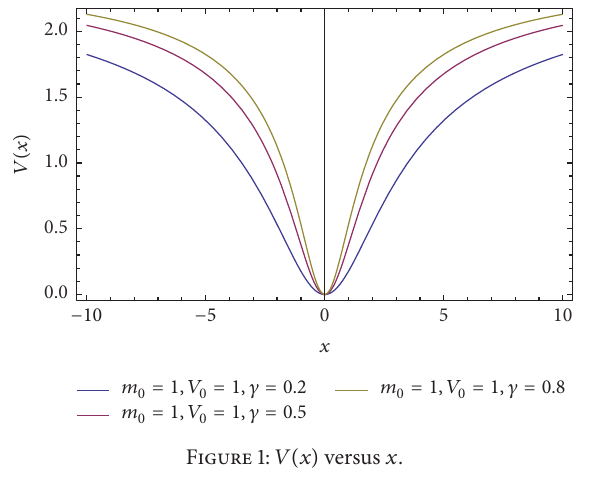
Figure 1: 𝑉(𝑥) versus 𝑥